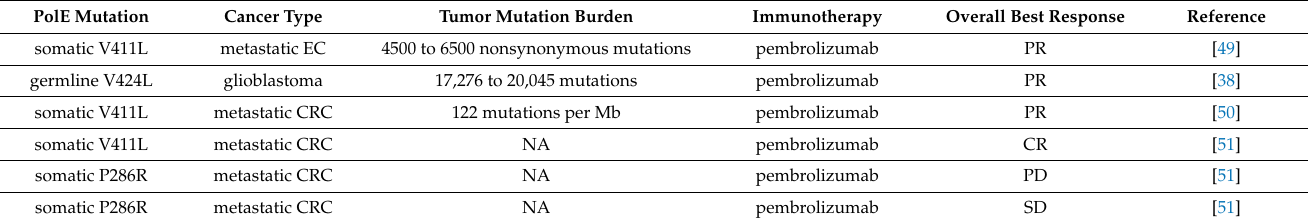
Table 1 summarizes the immunotherapy trials in PolE mutant cancers. Table 1. Immunotherapy in PolE mutant